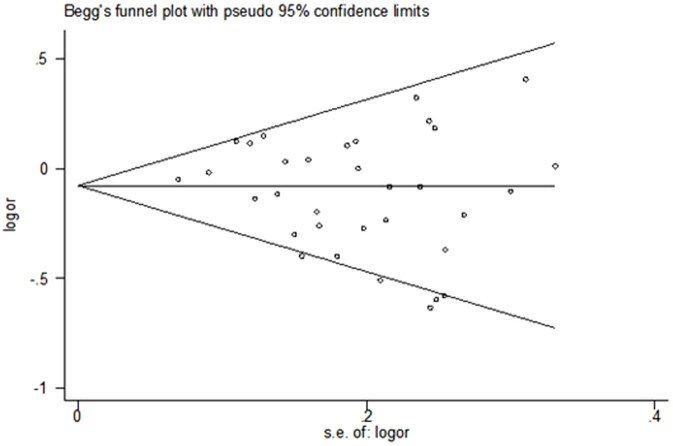
Funnel plot of publication bias.